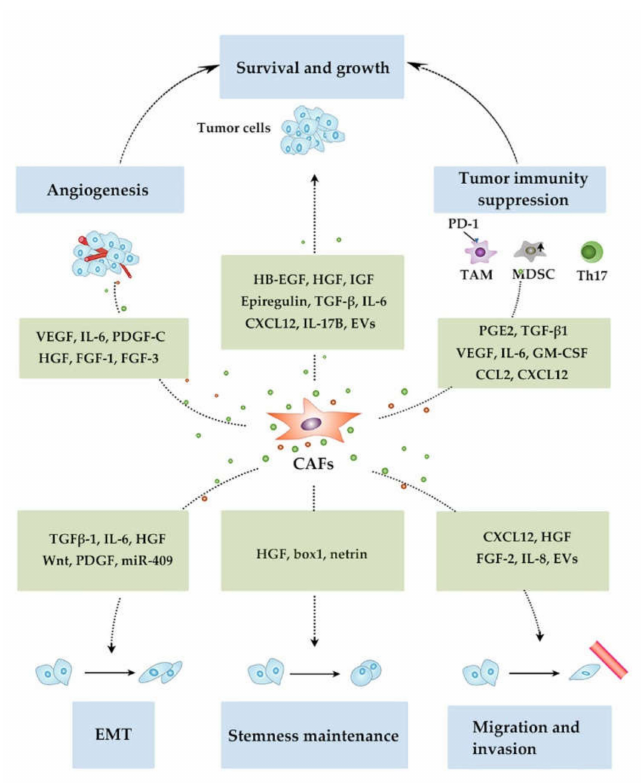
Figure 3. Functions of CAFs in tumor progression involved in